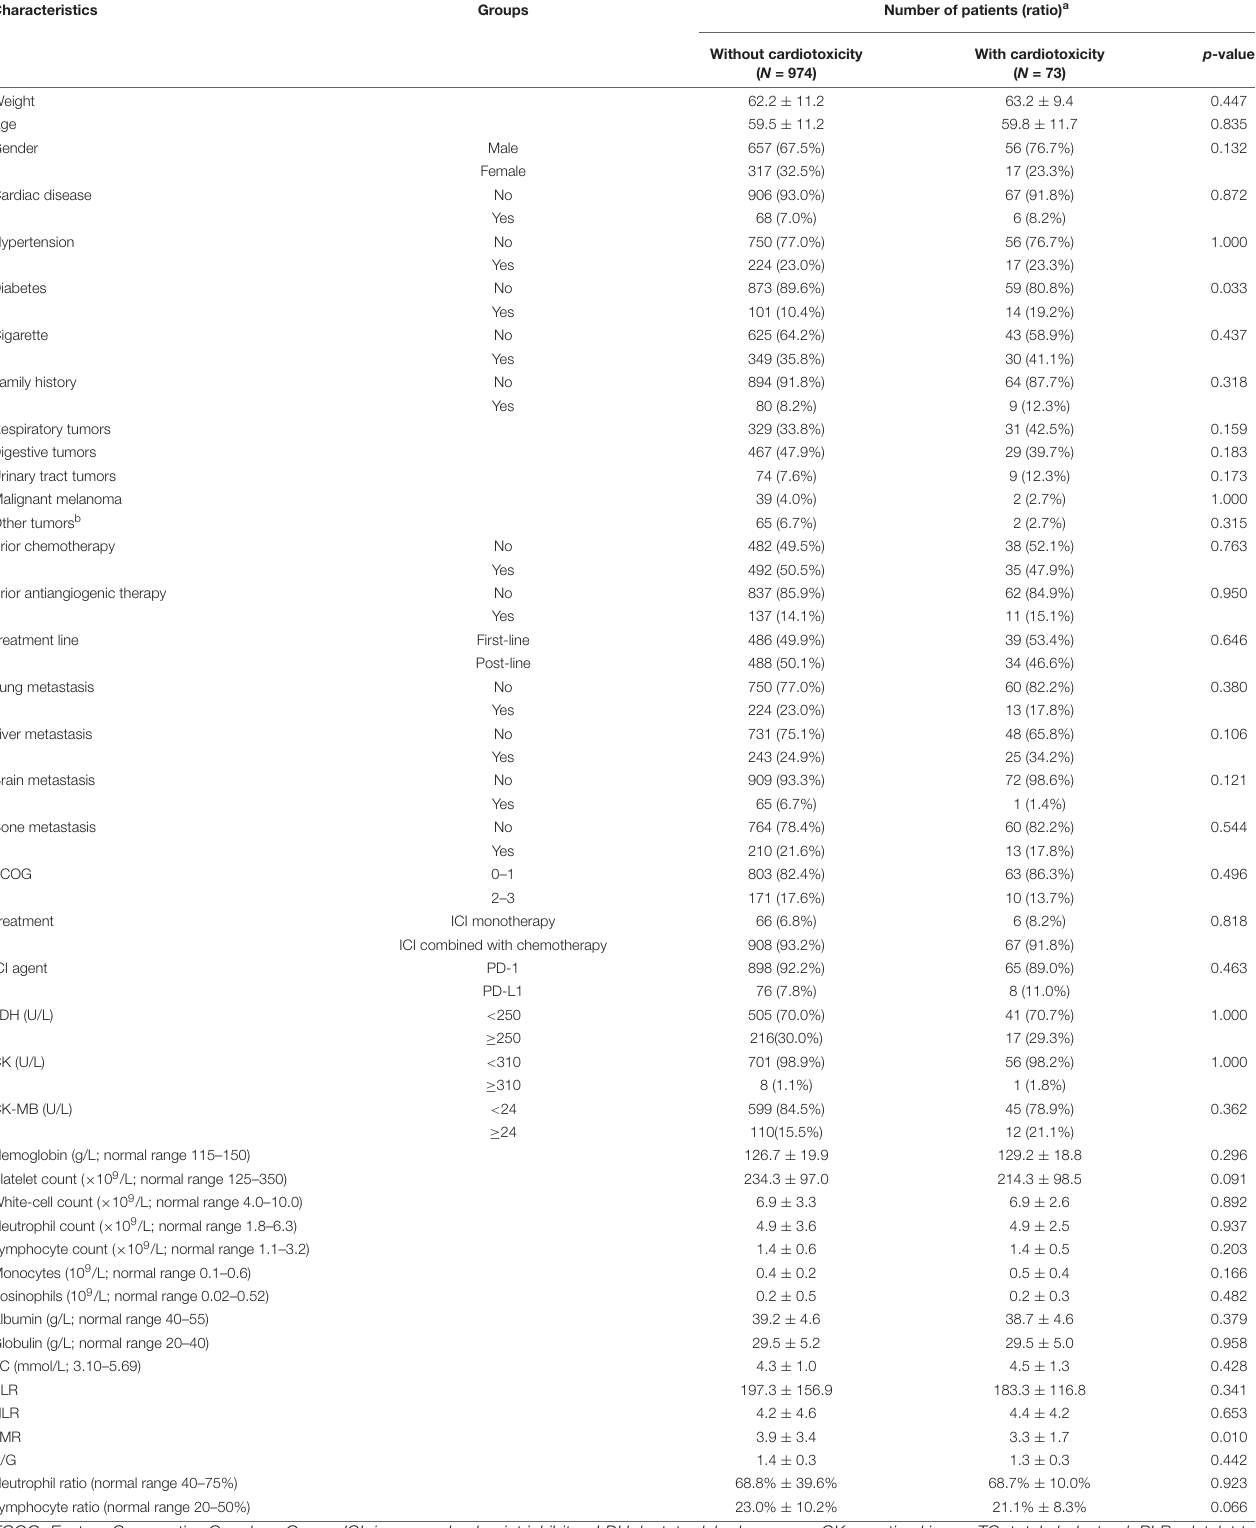
TABLE 2 | Characteristics of the whole population.